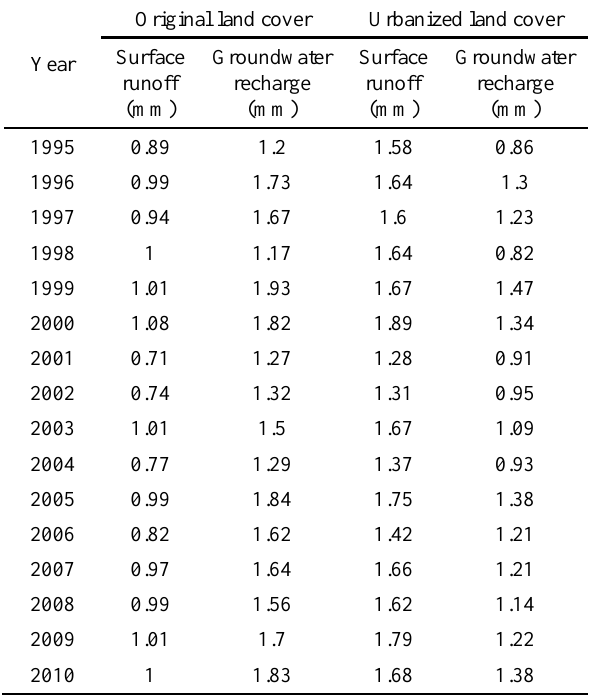
Table 5 . Annual Average Surface Runoff and Groundwater Recharge for Laguna de Bay